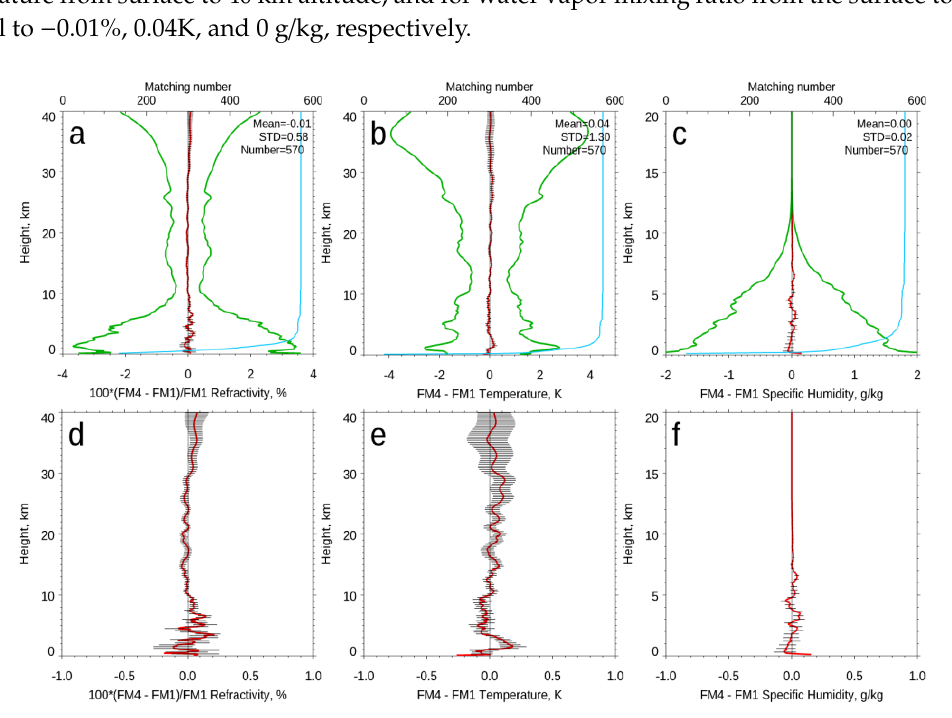
Figure 5. The mean di ff erence (in red line) and Median Absolute Deviation (MAD) (in green line) of ( a ) refractivity, ( b ) dry temperature, and ( c ) water vapor mixing ratio collected from DOY 211 through 300 of 2019 from COSMIC-2 FM4 and FM1 receivers. The mean di ff erence (precision) for ( d ) refractivity, ( e ) dry temperature, and ( f ) water vapor mixing ratio for the same data pairs but on a smaller x -axis scale (the range of x -axis is from − 1 unit to 1 unit) compared to those for ( a )–( c ), respectively.